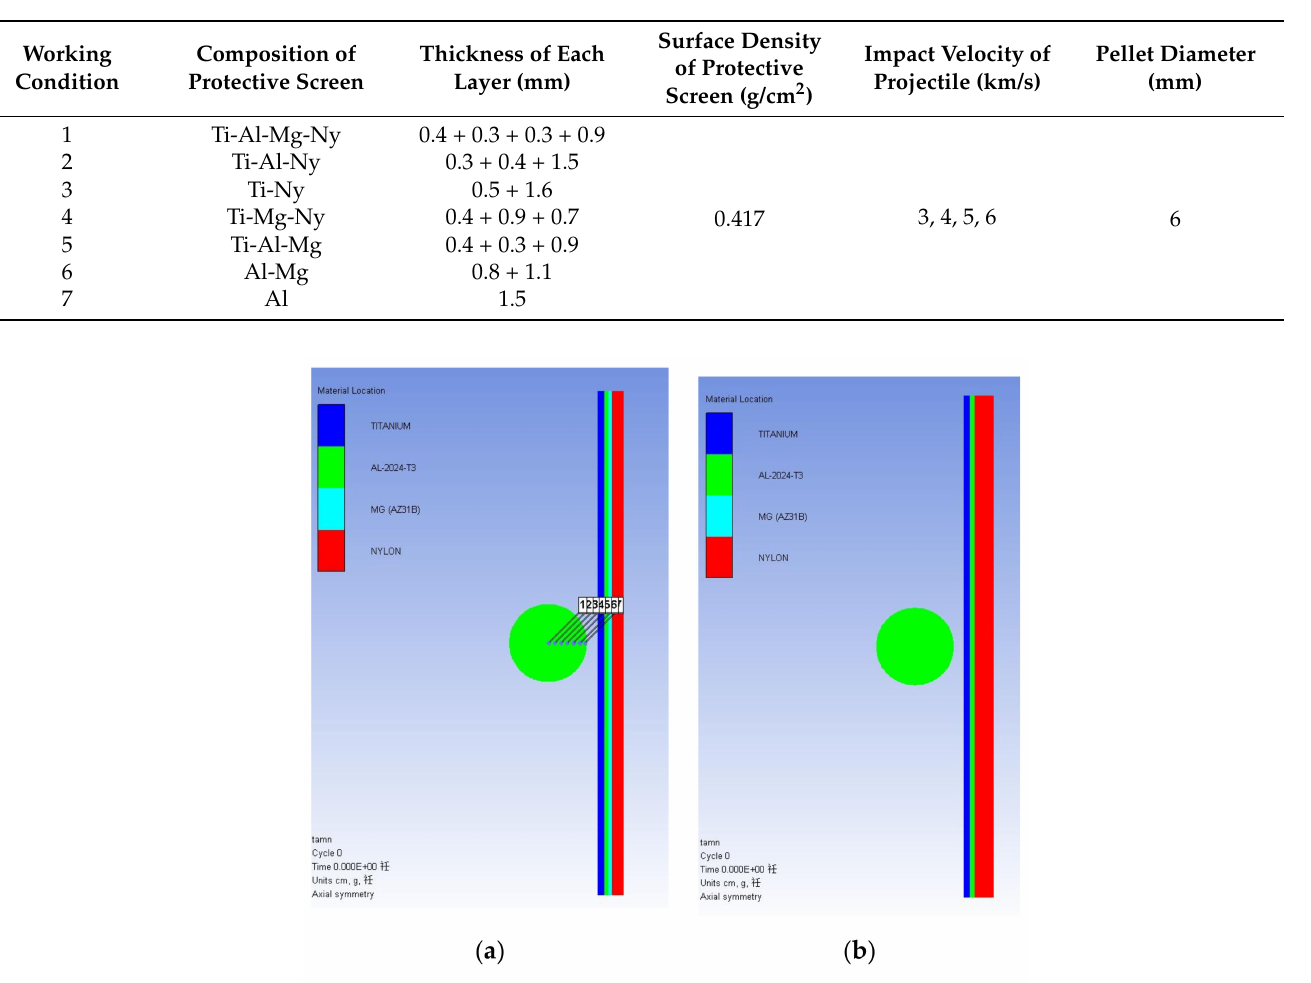
Table 4. Calculation-model parameters.